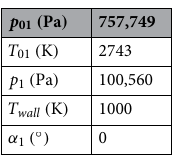
Table 1. Main flow boundary conditions.